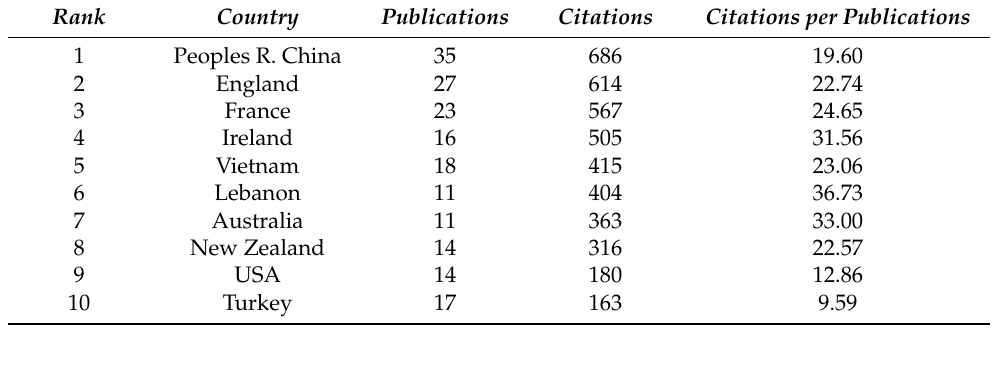
Table 5. Top 10 countries by number of citations.